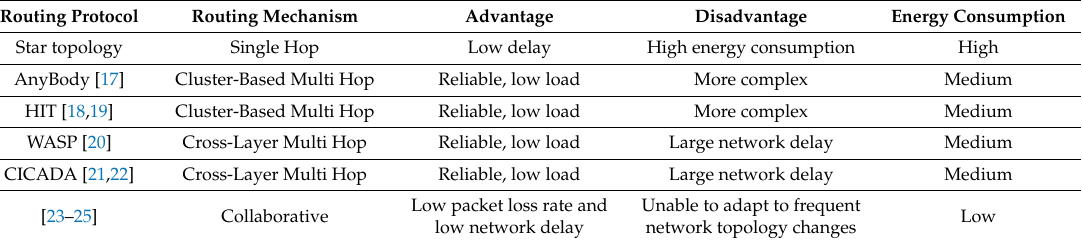
Table 1. Comparative Analysis of Different Routing